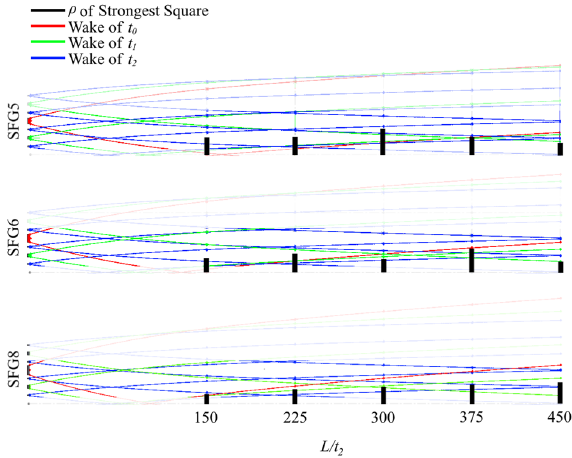
Figure 6. Wake of fractal grid bars superimposed for each bar thickness. (note: prepared in Paint.net 4.2.14, https:// www. getpa int. net).